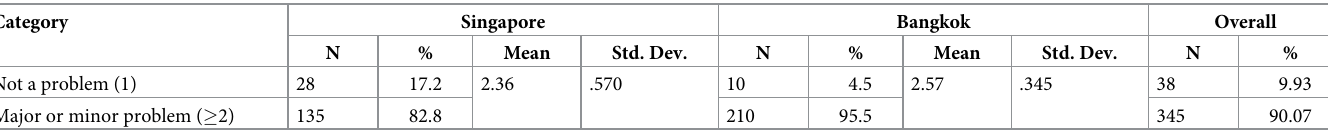
Table 2. Perceived severity index.